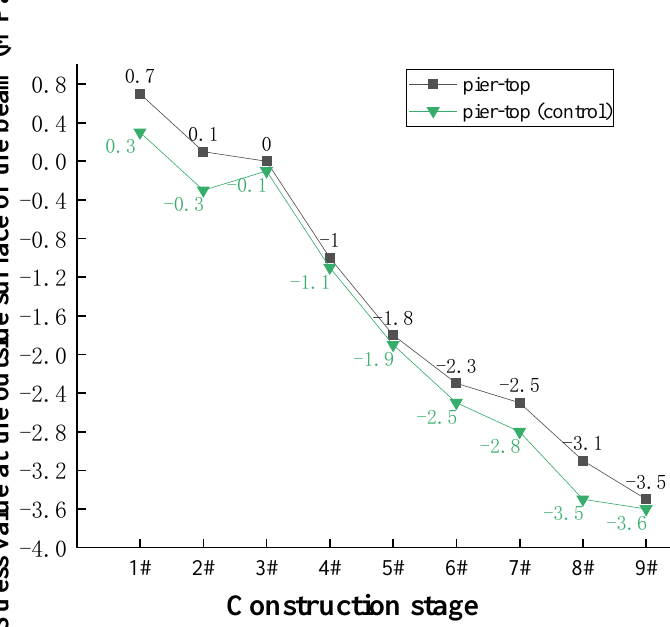
Figure 13. Stress value at the outside surface of the beam.